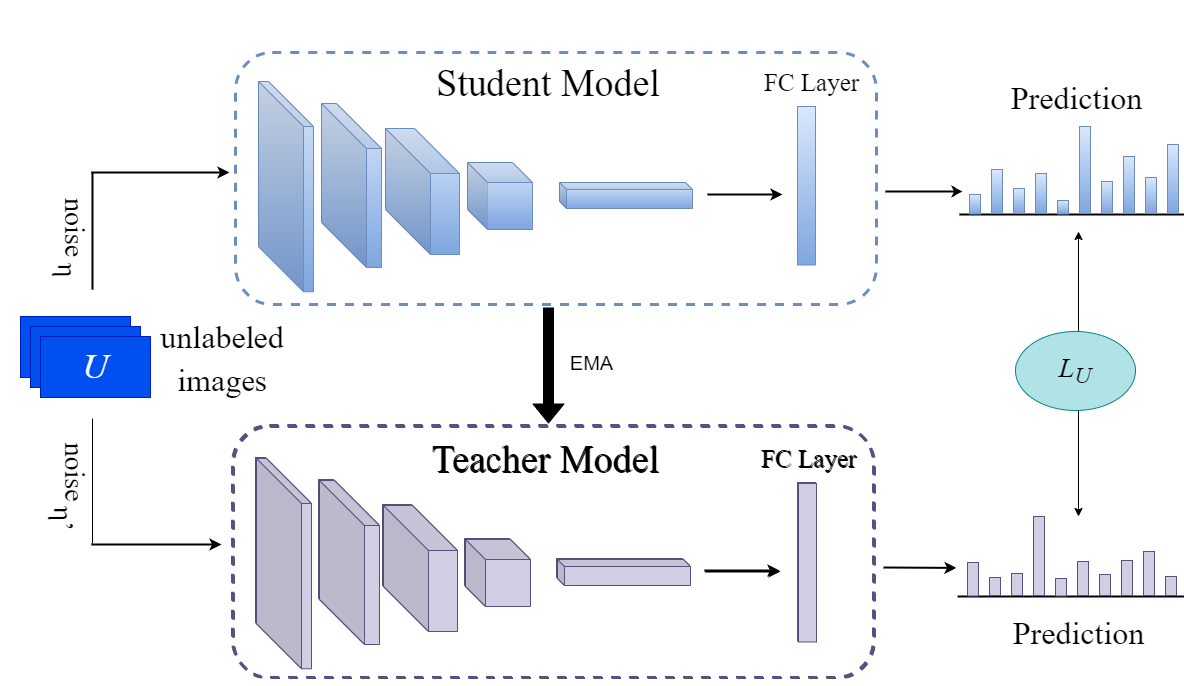
Figure 4. Unsupervised framework in the semi-supervised model.